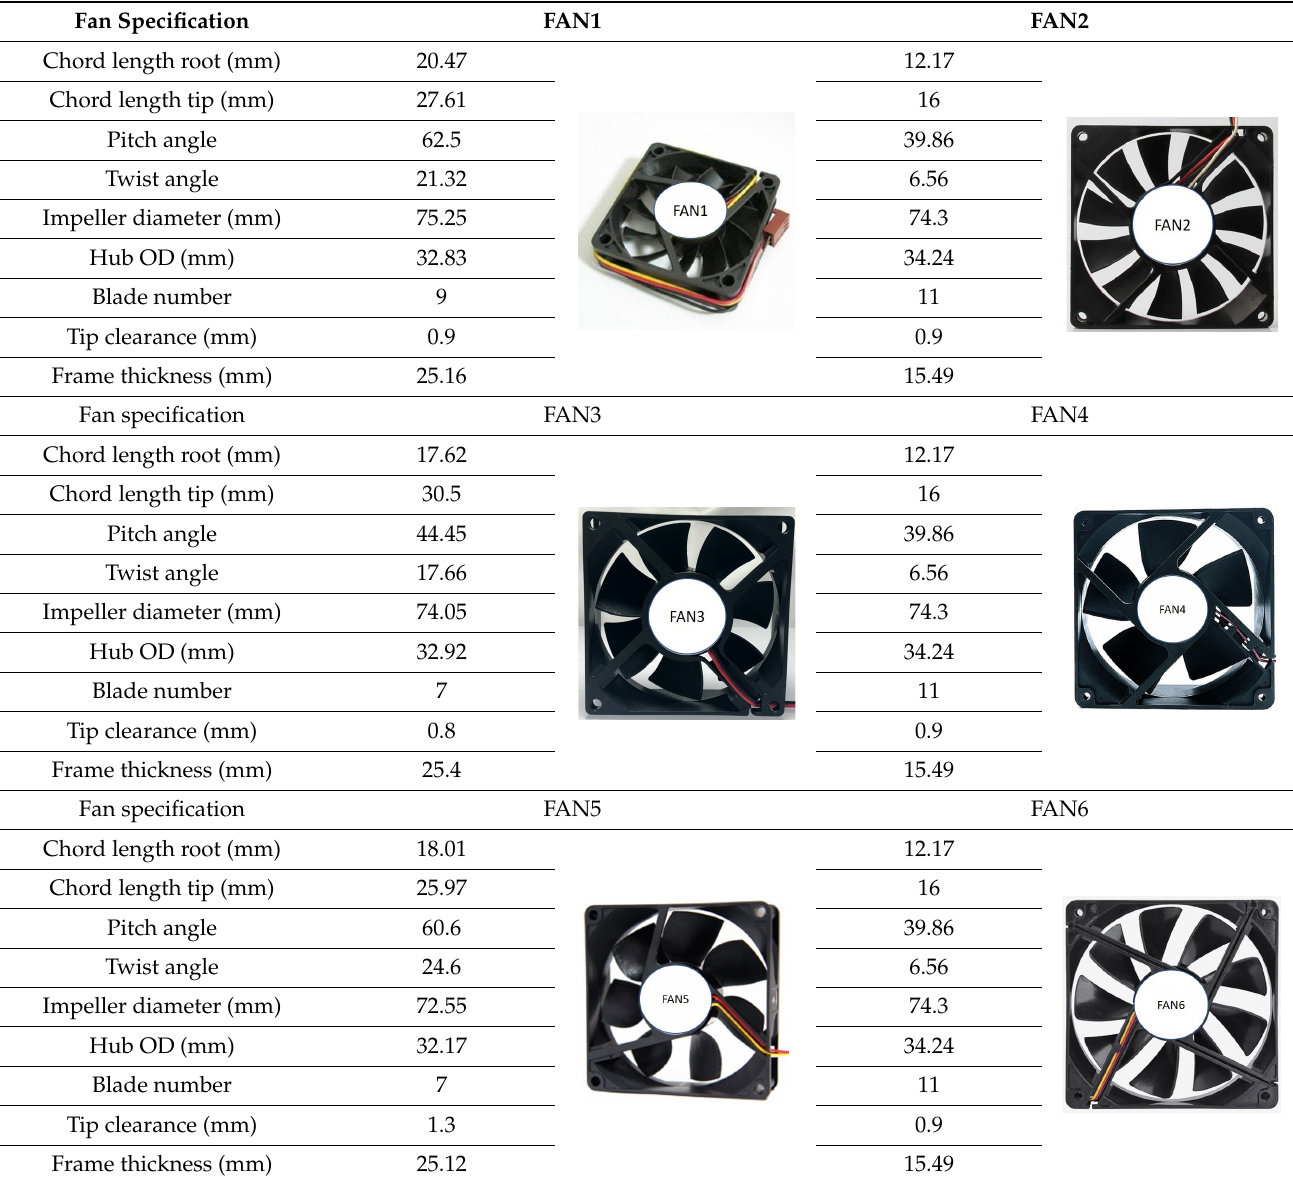
Table 2. Fan characteristics.